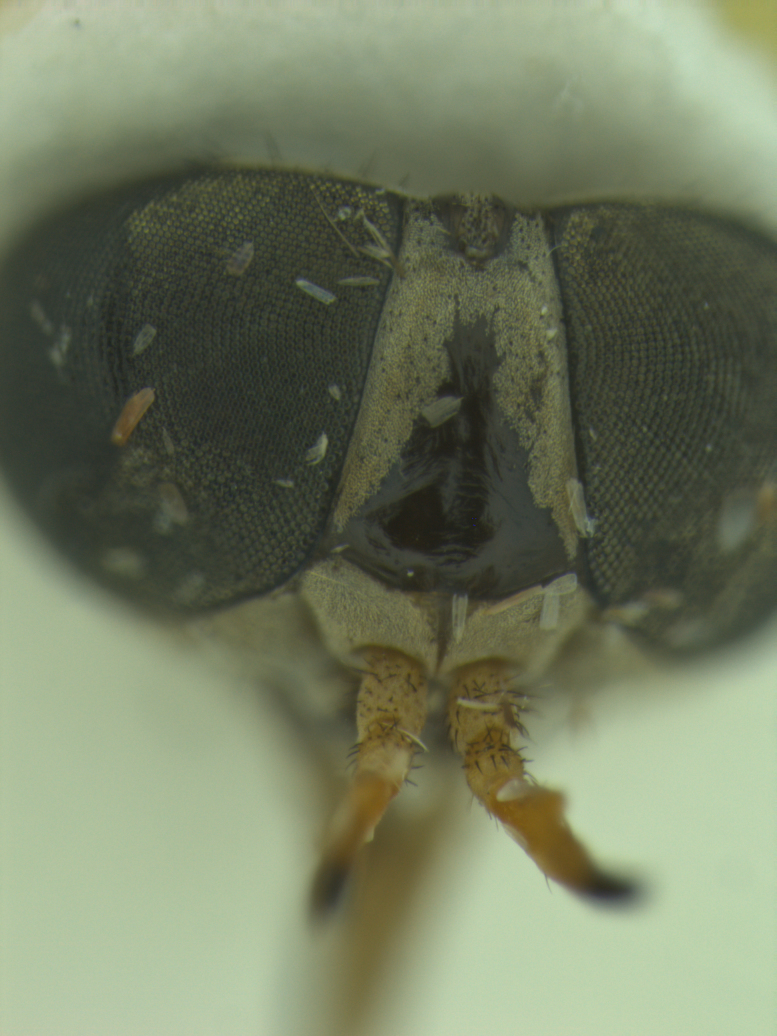
Head, frontal view.